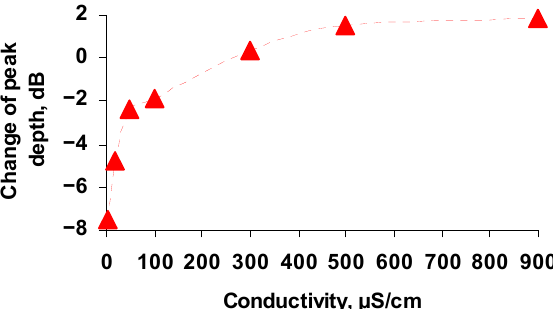
Figure 9. The dependence of the change in the depth of the resonance peak for the suspension with TGE virus upon addition of anti-TGEV antibodies near the frequency of 2.82 MHz on the conductivity of the buffer solution.